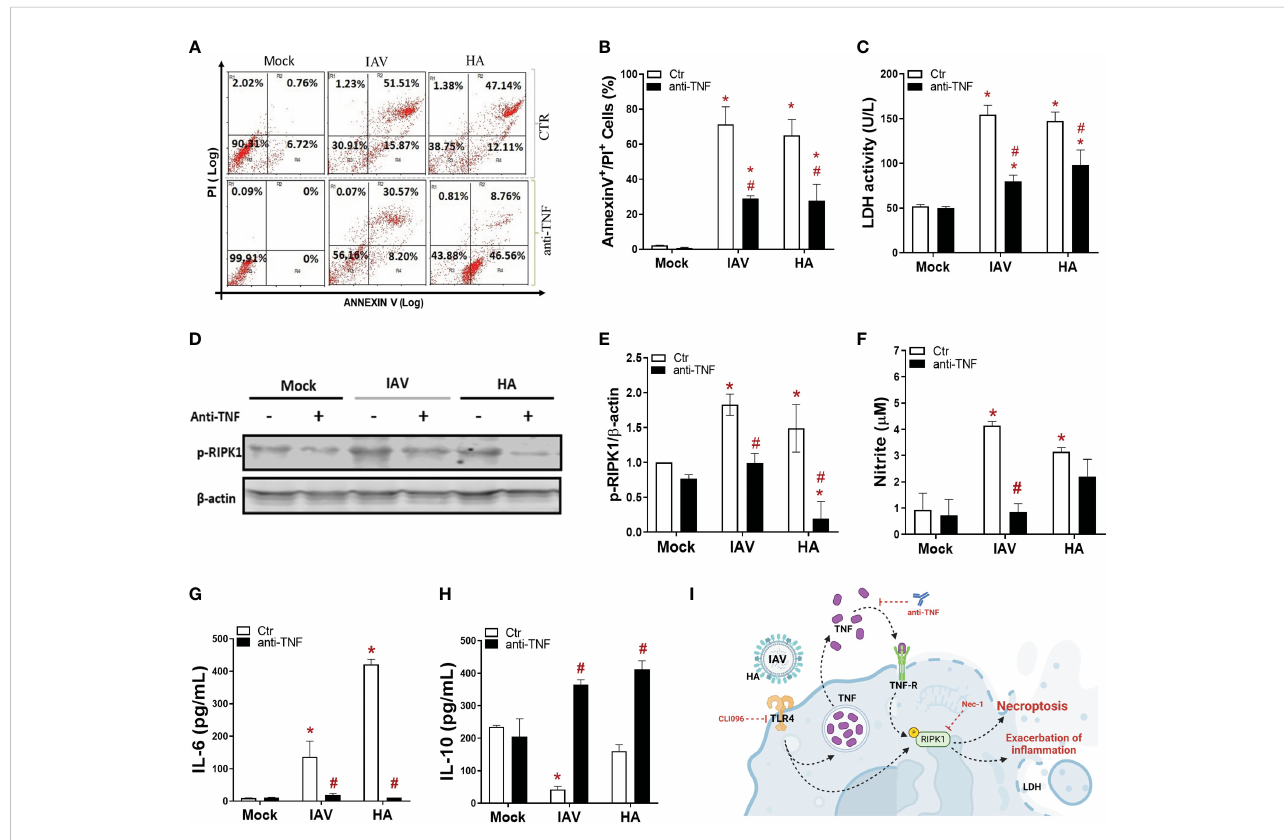
FIGURE 3 IAV- and HA-induced in fl ammatory programmed cell death is dependent on TNF. Macrophage cultures were pretreated with 1 ng/mL anti-TNF- a antibody and then infected with IAV (MOI of 0.25) or exposed to 10 ng/mL viral HA for 24 h. Cell death analysis was performed by fl ow cytometry analysis of annexin V/PI-positive cells (A, B) . Assessment of cell viability through the measurement of LDH release in the supernatant of BMDMs (C) . (D) The expression of p-RIPK1 was detected in BMDMs by Western blotting. b -actin levels were used as a control for protein loading. (E) Graphs of band densitometry obtained after loading normalization and expressed as fold change over mock untreated control. (F) Levels of nitrite were measured by the Griess method in the supernatant of BMDM cultures after 24 h of stimulus. The levels of (G) IL-6 and (H) IL-10 were measured by ELISA in the supernatant of BMDM cultures after 24 h of stimulation. Data are presented as the mean ± SEM of 5 independent experiments *P < 0.05 versus untreated control group (MOCK); # P < 0.05 versus respective untreated infected/stimulated group. (I) Model of A/HA-triggered necroptosis. IAV/HA triggered necroptosis by a loop of events involving TLR4, TNF- a , and RIPK1, leading to exacerbation of in fl ammation. Images were created with